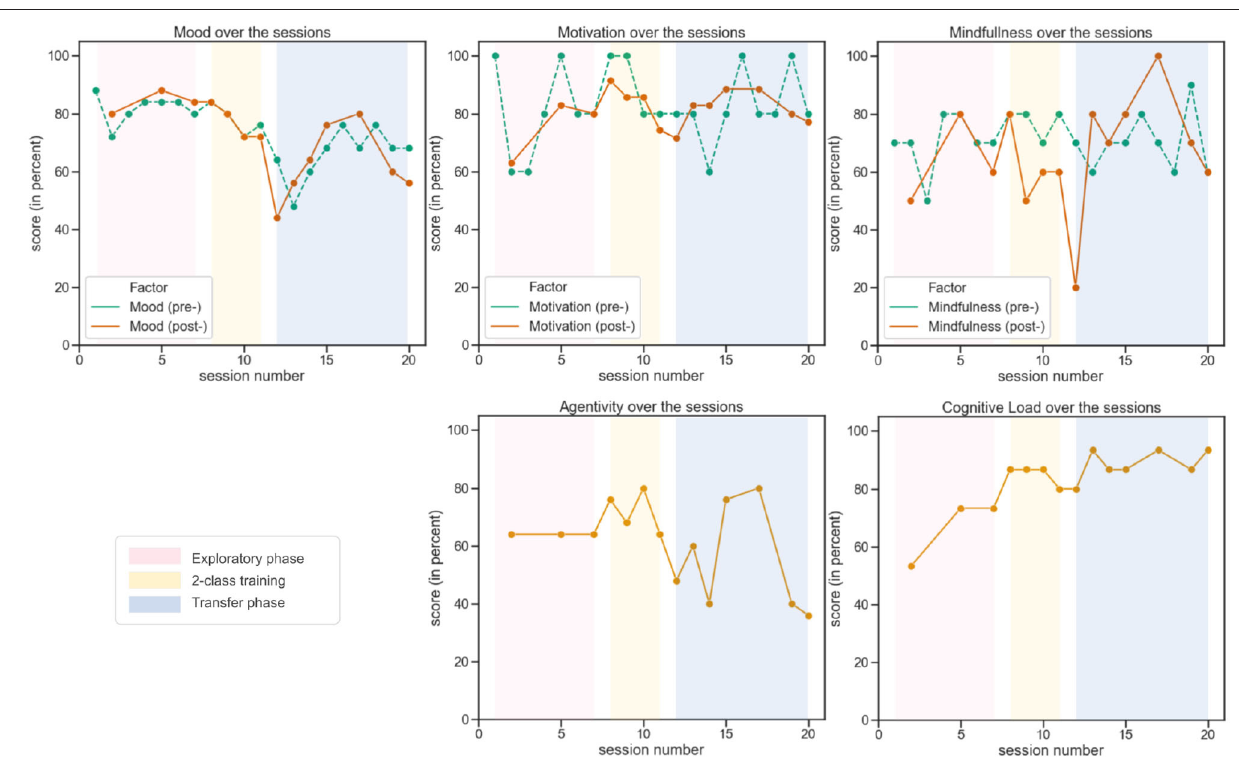
Frontiers in Human Neuroscience |